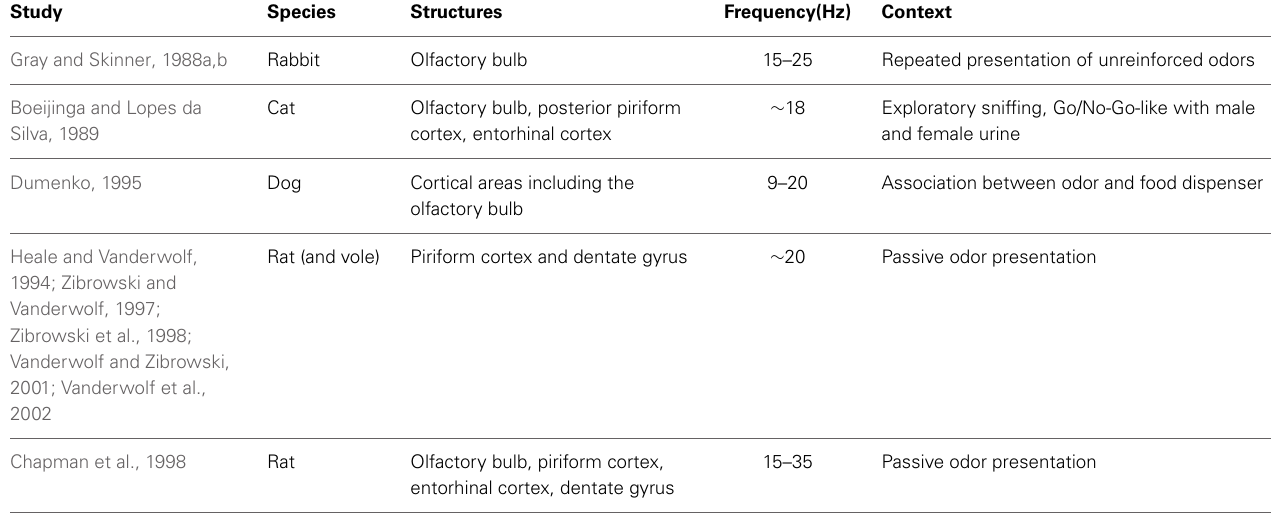
Table 1 | Beta oscillations recorded during odor presentation in awake